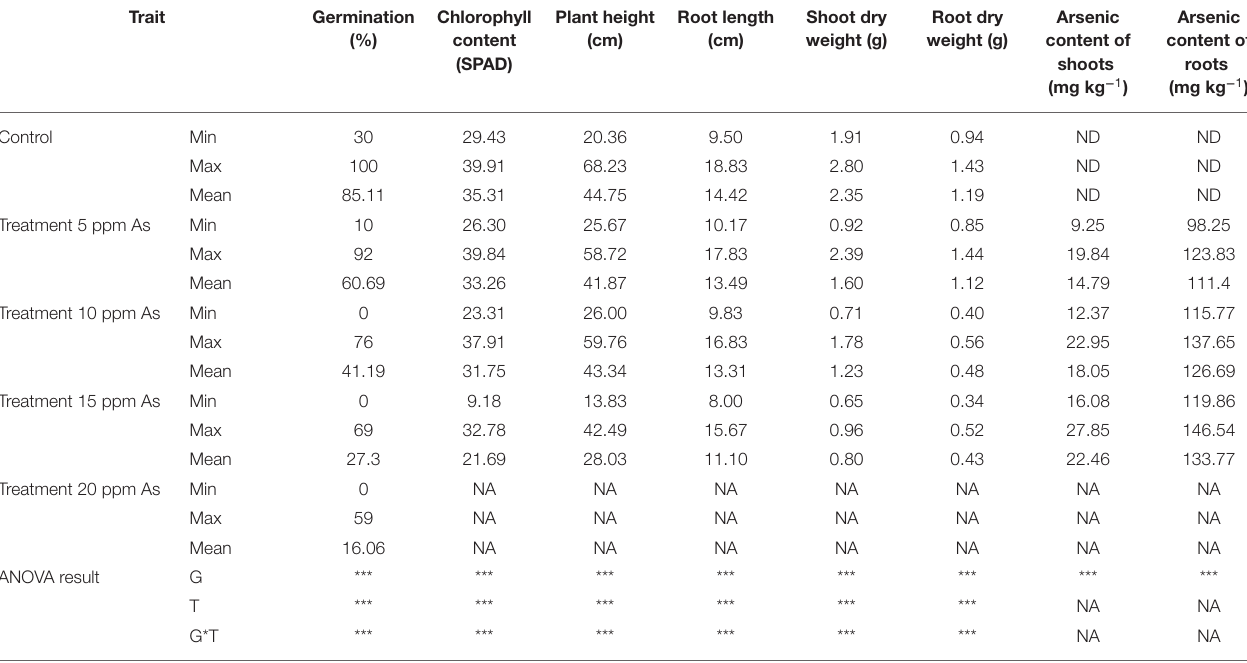
TABLE 2 | Descriptive statistics and ANOVA results for measured phenotypes.